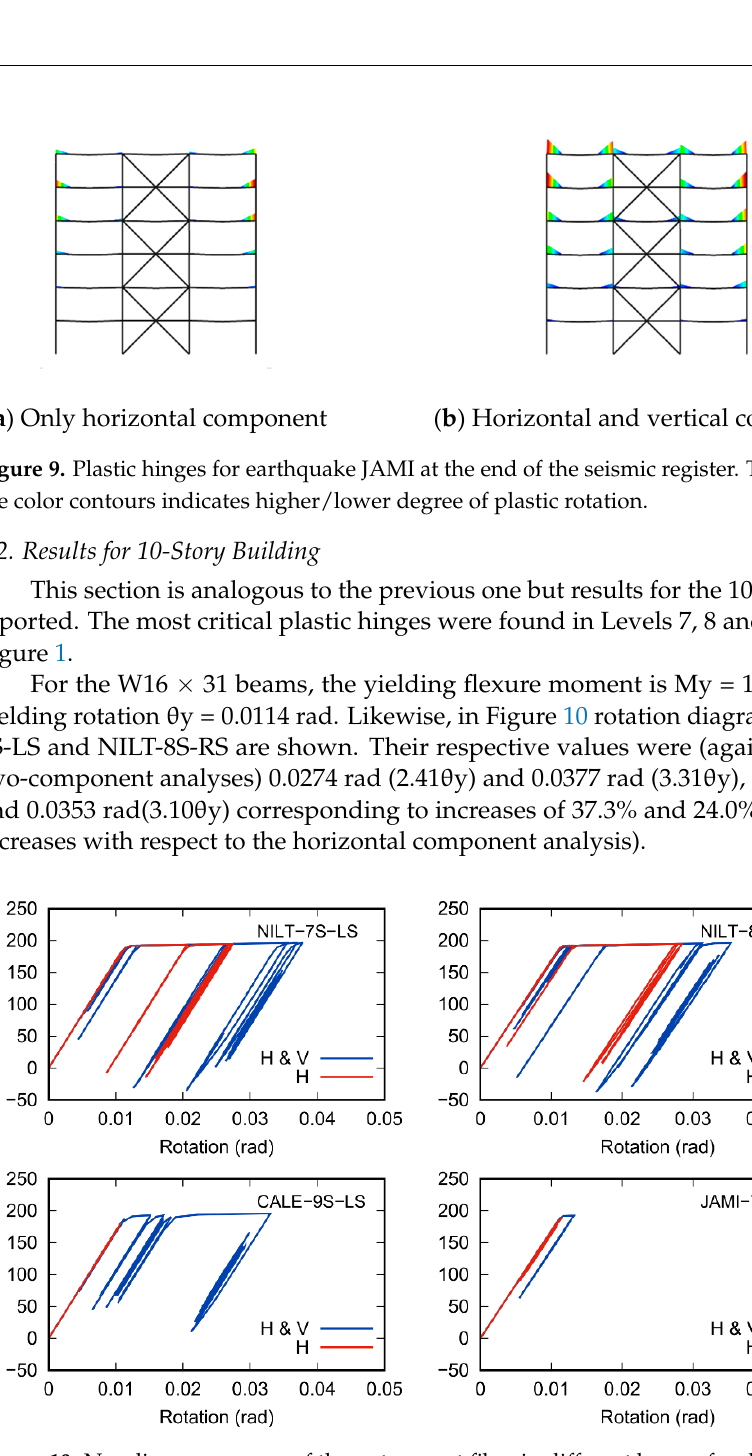
Figure 11. Non-linear response of the outer-most fiber in different beams for different earthquakes; 10-story buildings (Part 2). The response to the earthquake of station LANE-7S-LS is depicted in Figure 11, led to 0.0130 rad (1.14θy) and 0.0178 rad (1.56θy) for the one - and two-component analysis,